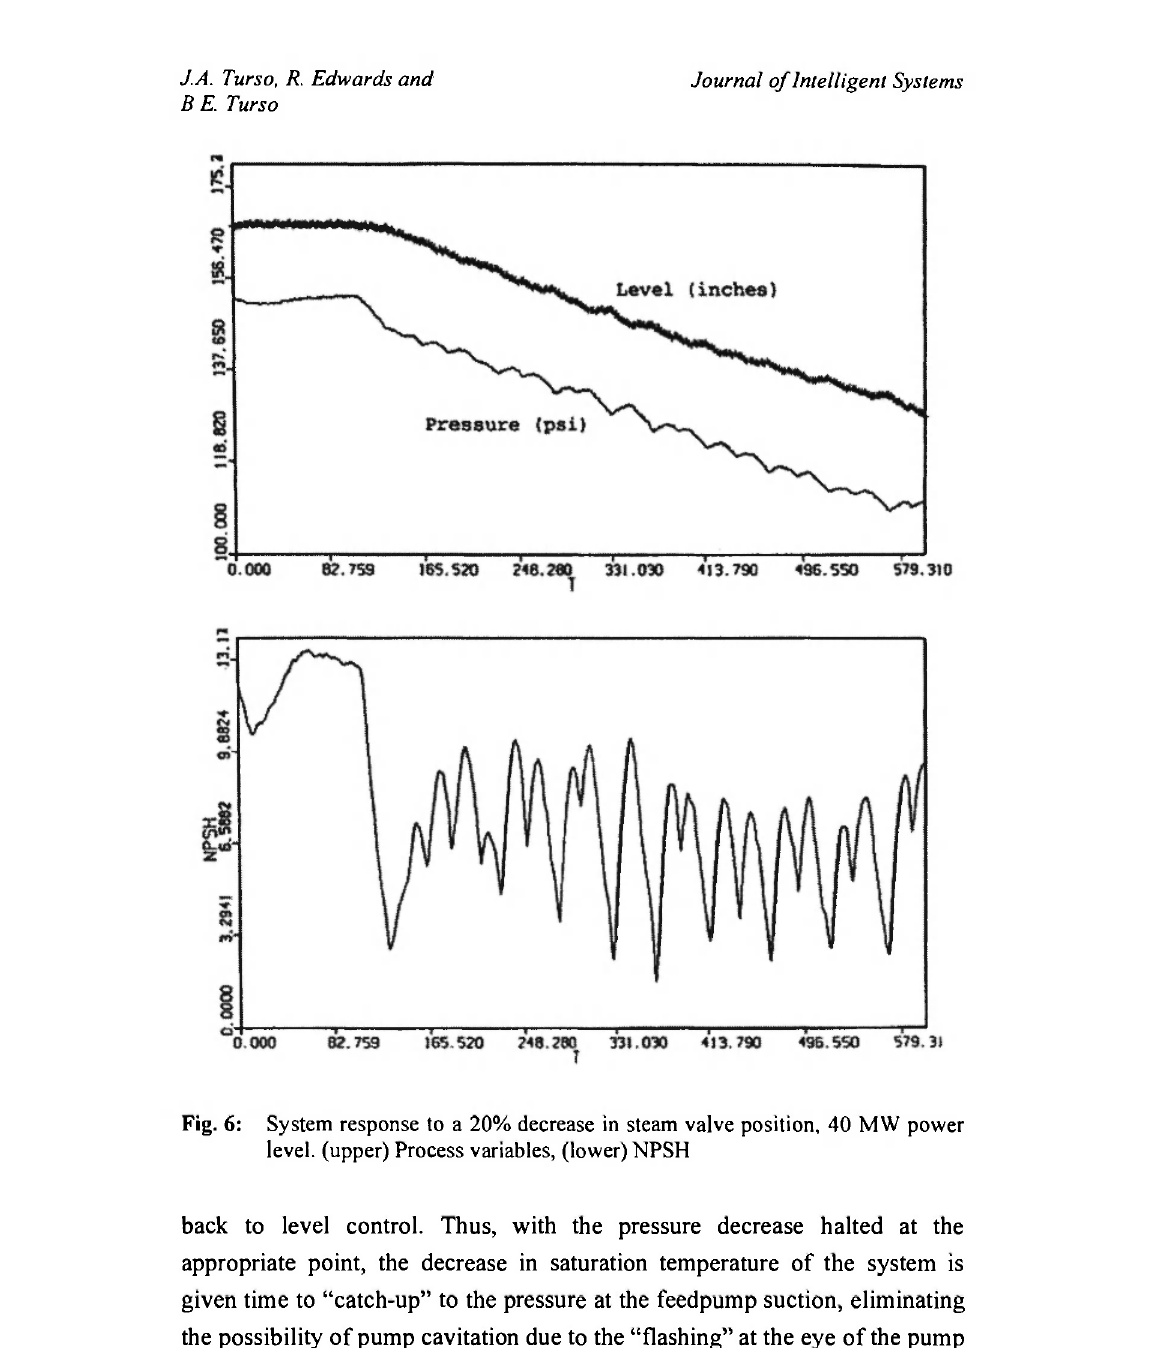
back to level control. Thus, with the pressure decrease halted at the appropriate point, the decrease in saturation temperature of the system is given time to "catch-up" to the pressure at the feedpump suction, eliminating the possibility of pump cavitation due to the "flashing" at the eye of the pump results in a rapid decrease in NPSH. As the anomaly progresses, the output of the ANN decreases until the status of the system has degraded to the point where a reconfiguration from level to pressure control is